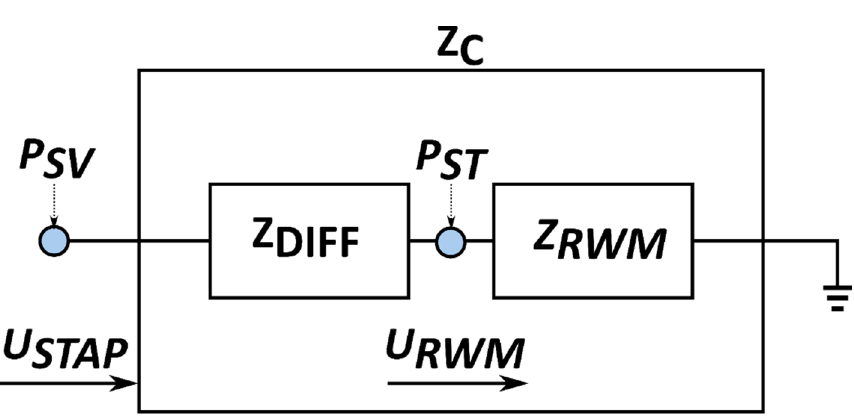
Figure 8. LEM circuit of the cochlea proposed by Nakajima et al. (2009). Ground connection represents the sound pressure at the surgically opened middle ear cavity that is assumed to be zero.